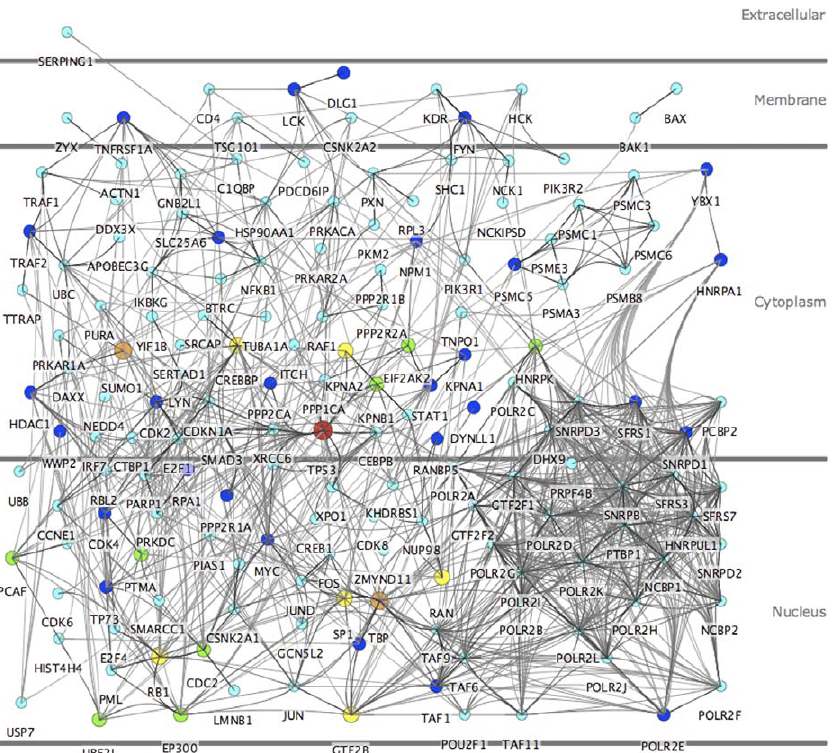
Figure 1. Human Proteins Interacting with Multiple Viral Pathogen Groups The network of interactions between human proteins interacting with at least two viral pathogen groups. The size and color of a protein denote the number of pathogen groups that interact with it: light blue is two, dark blue is three, green is four, yellow is five, orange is six, and red is